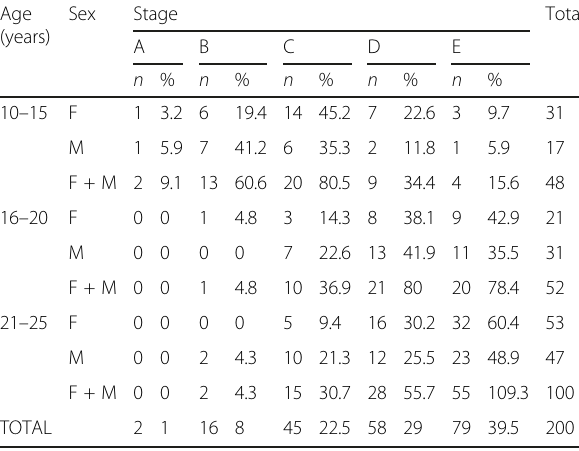
Table 1 Distribution of the MPS maturational stages by age group and